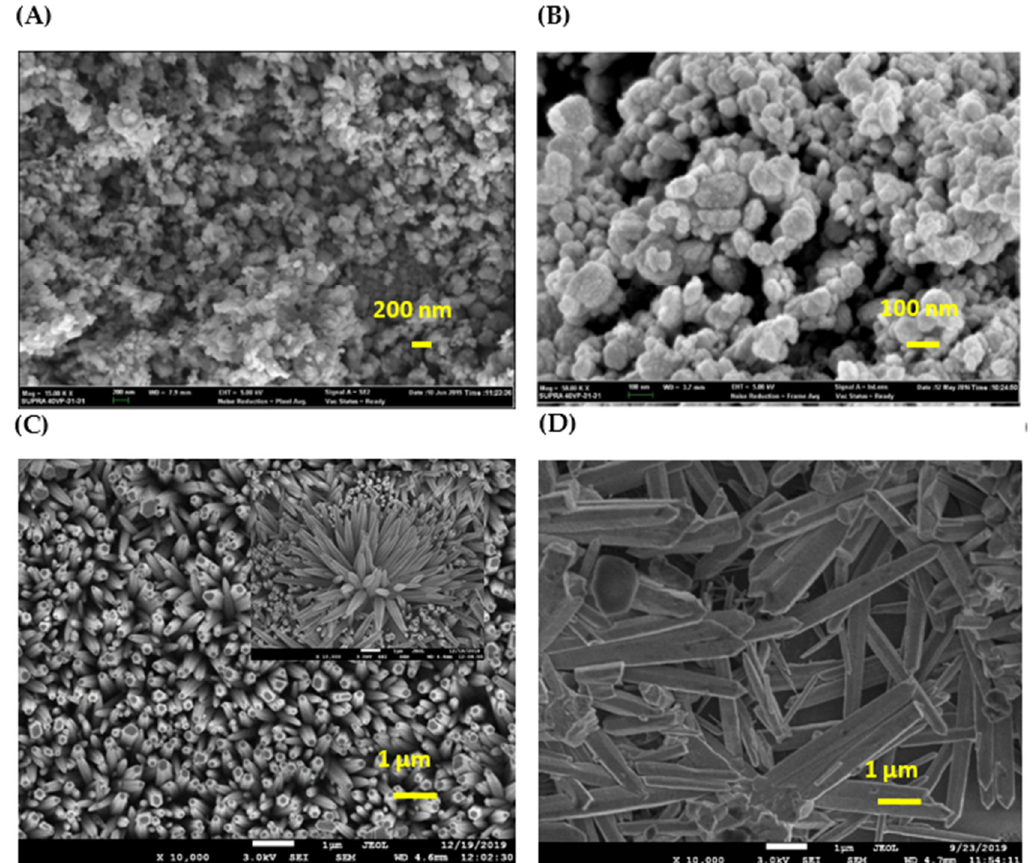
Figure 8. FESEM of ( A ) ZnO nanoparticles using Zn-HMTA, ( B ) ZnO nanoparticles using Zn-Pandan, ( C ) ZnO nanorods using Zn-HMTA seed layer, and ( D ) ZnO microrods using Zn-Pandan seed layer.